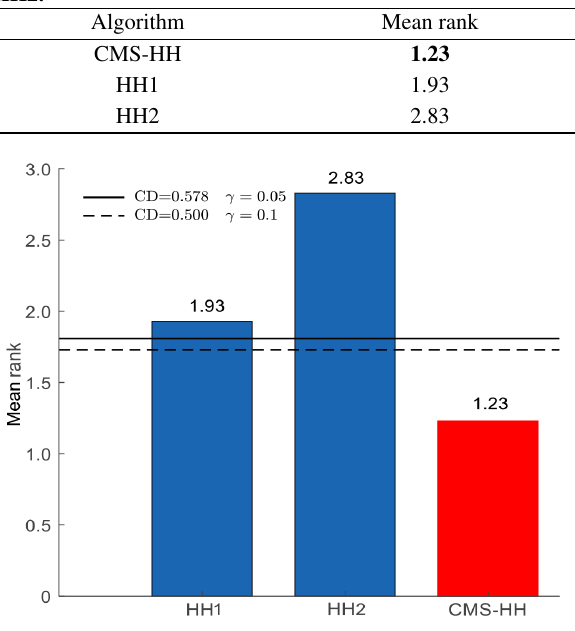
Fig. 2 Mean rank of the